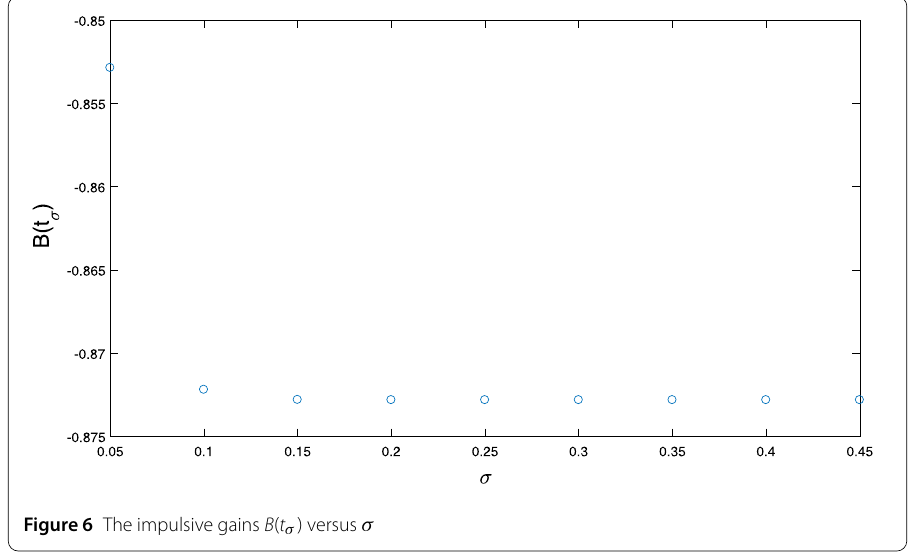
Figure 6 The impulsive gains B ( t σ ) versus σ